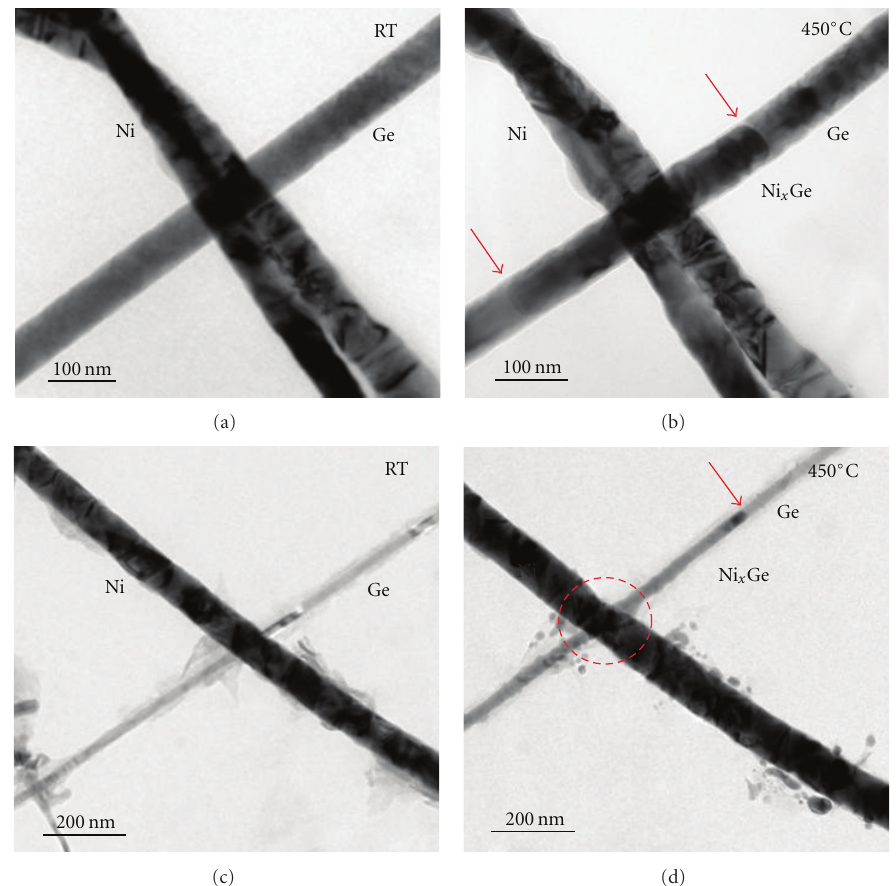
Figure 11: (a) TEM image of a Ge nanowire in point-contact with two Ni nanowires on the TEM grid at room temperature. (b) TEM image showing the di ff usion of Ni into the Ge nanowire upon 450 ◦ C annealing. The red arrows indicate the growth tip of the Ni x Ge nanowire. (c) TEM image of another Ge nanowire in point contact with a Ni nanowire on the TEM grid at room temperature. (d) TEM image showing the di ff usion of Ni into the Ge nanowire upon 450 ◦ C annealing. The red circle highlights the consumption of Ni in the formation of the Ni x Ge nanowire upon annealing. Also, the segregation of Ni x Ge nanoparticles was not observed in the Ni-Ge nanowire point-contact system upon